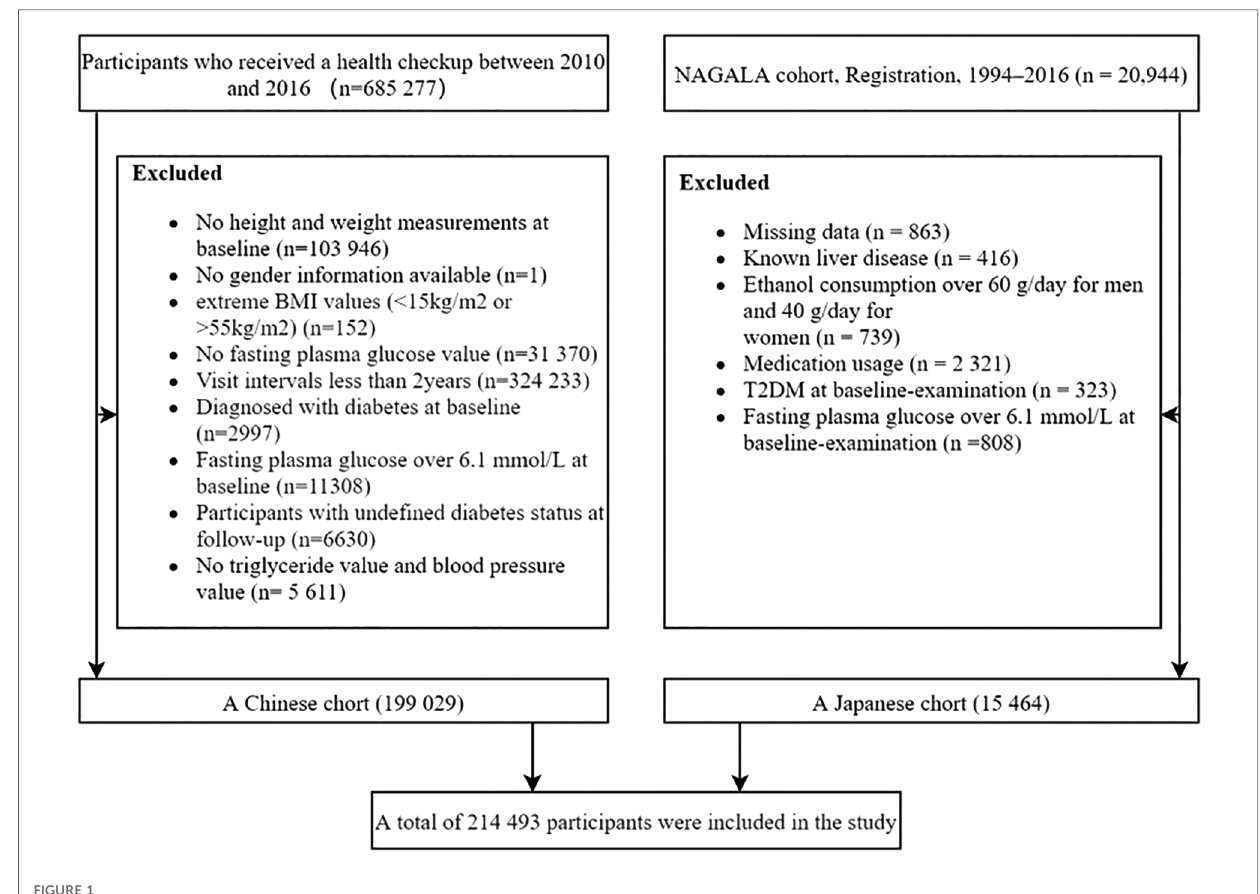
FIGURE 1 Flowcharts for study